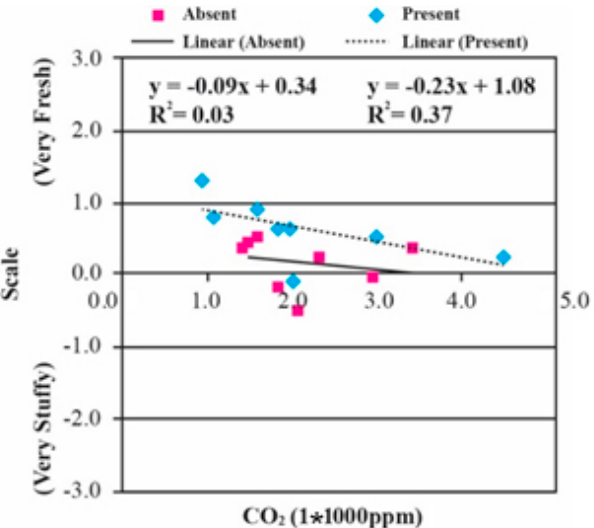
Figure 13. The frequency of concentration with or without plant placement.